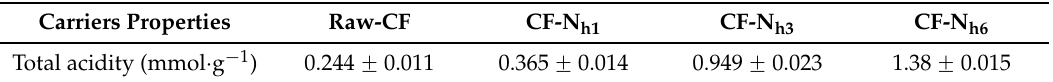
Table 1. The content of total acidic functional groups in raw and treated carbon fibers.